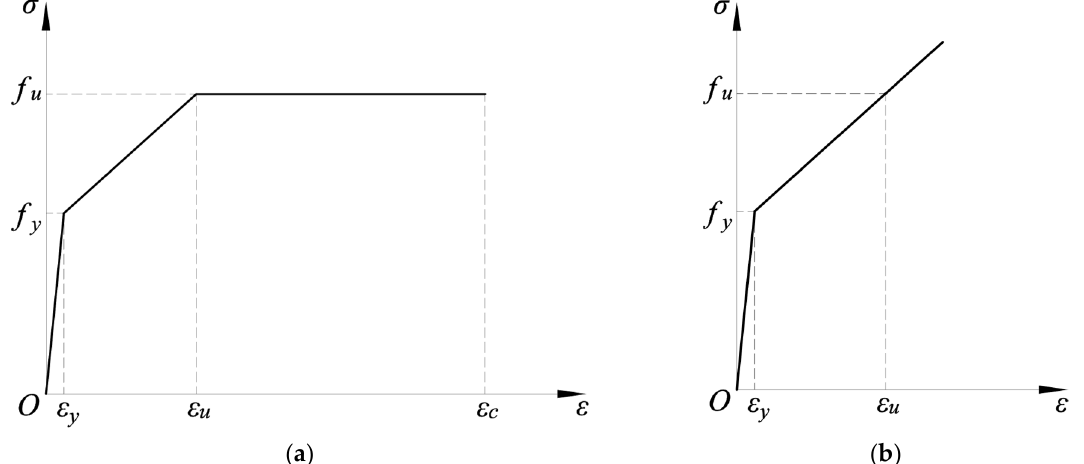
Figure 4. Stress–strain curve of steels in FEM model: ( a ) trilinear model (applied to members except bolts or base beam); ( b ) bilinear model (applied to bolts).